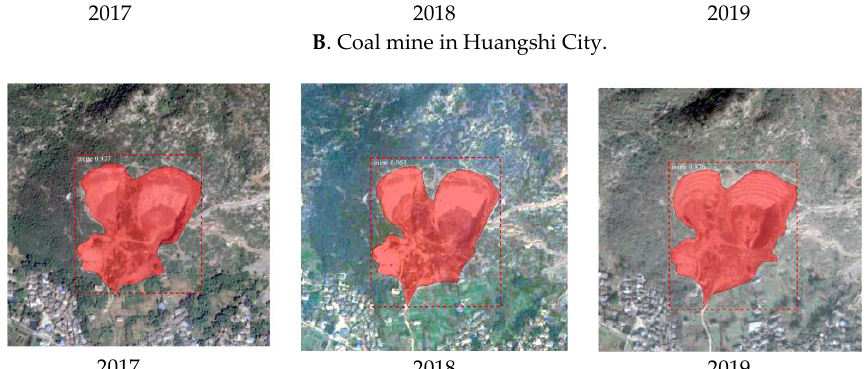
Figure 12. Open-pit mine changes from 2017 to 2019.